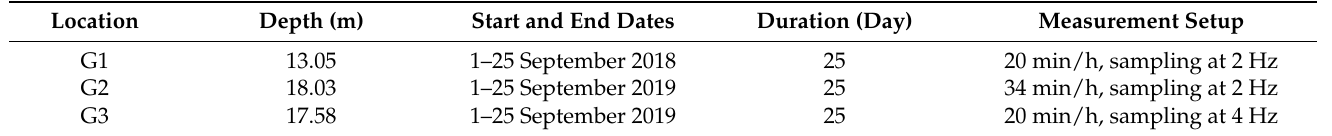
Table 1. Characteristics of observed data used in this study.